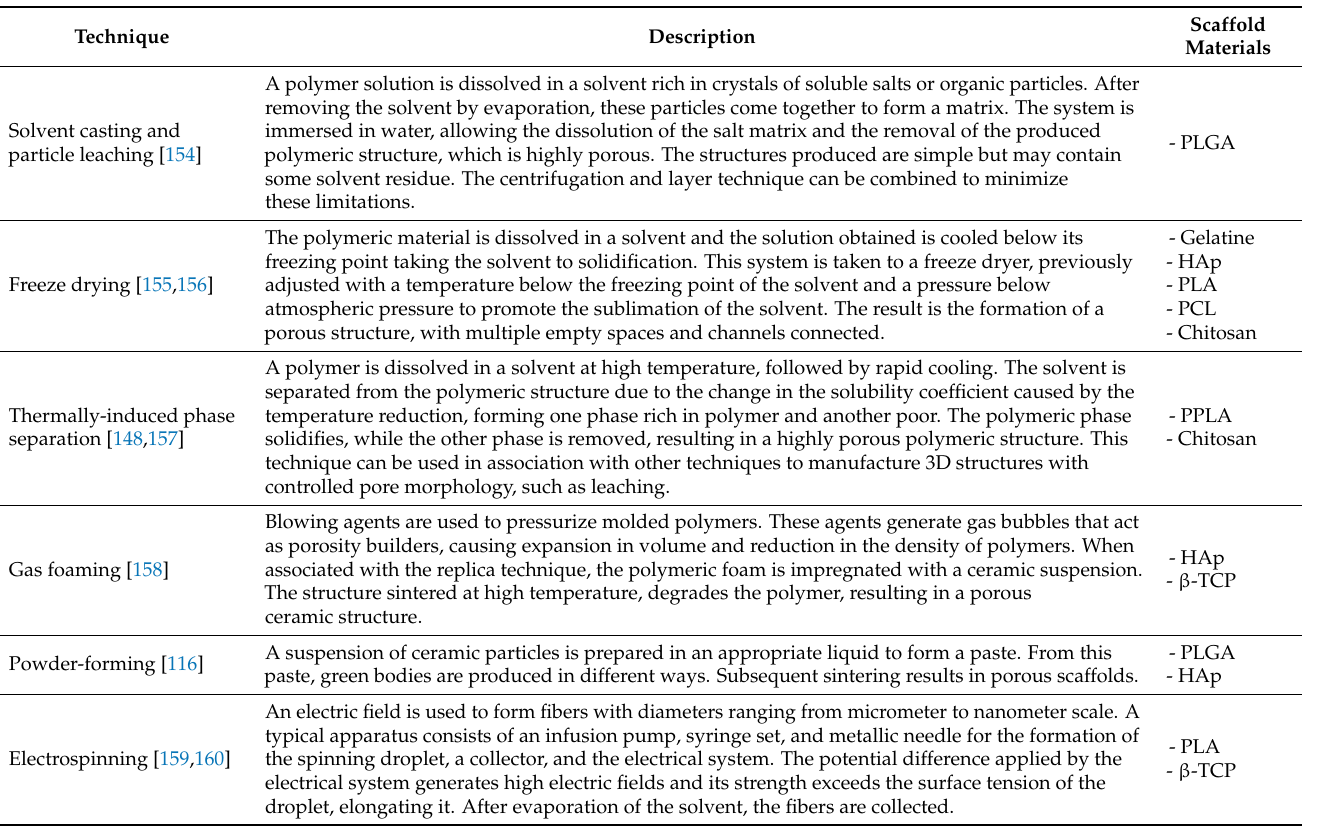
Table 2. Conventional manufacturing techniques: description and typical scaffold